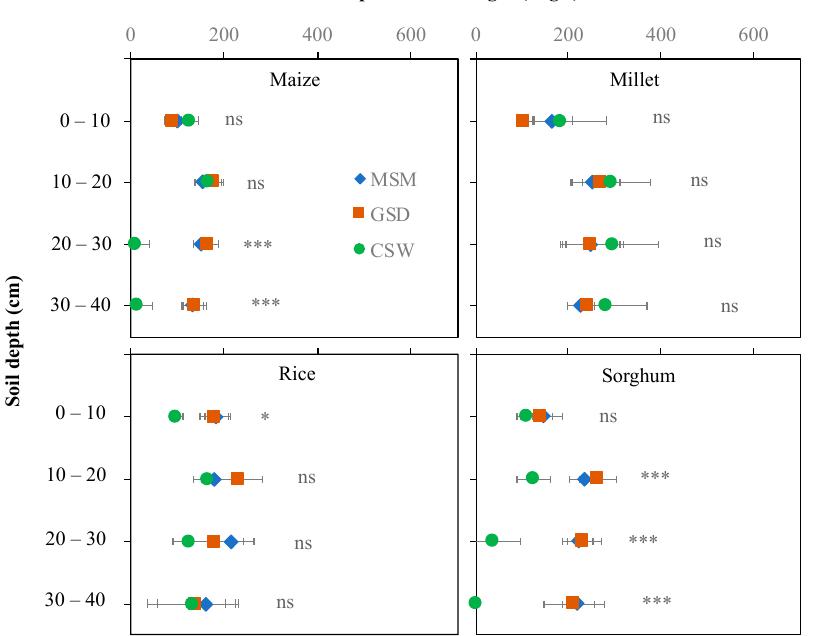
Figure 5. Specific root length distribution in different soil layers of maize, millet, rice, and sorghum grown under moderate soil moisture (MSC ( ◆ )), gradual soil drying (GSD ( ■) ) and continuous soil waterlogging (CSW ( ● )). *, ***, and ns indicate statistical significance at p < 0.05, p < 0.001, and nonsignificance, respectively.